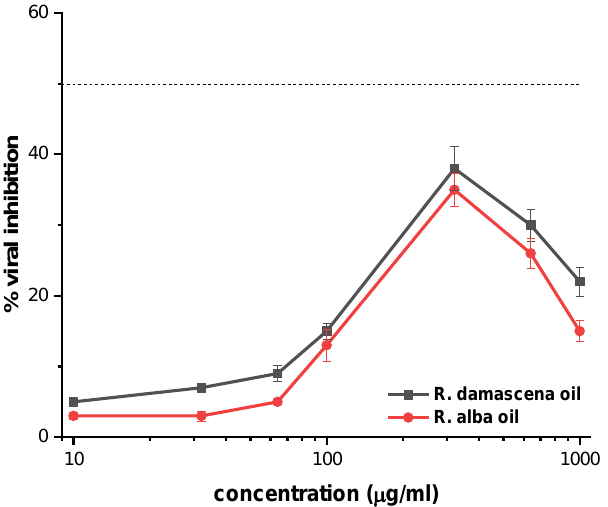
Figure 2. Antiviral activity of Rosa damascena Mill. and Rosa alba L. essential oils on the one replication of HSV-1. The experimental conditions are described in Section 2.6.